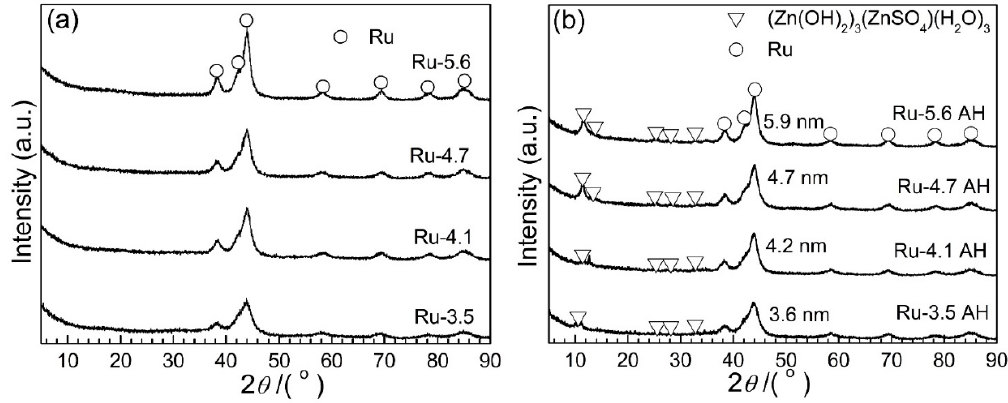
Figure 9. XRD patterns of Ru catalysts with the different particle size before ( a ) and after ( b ) catalytic